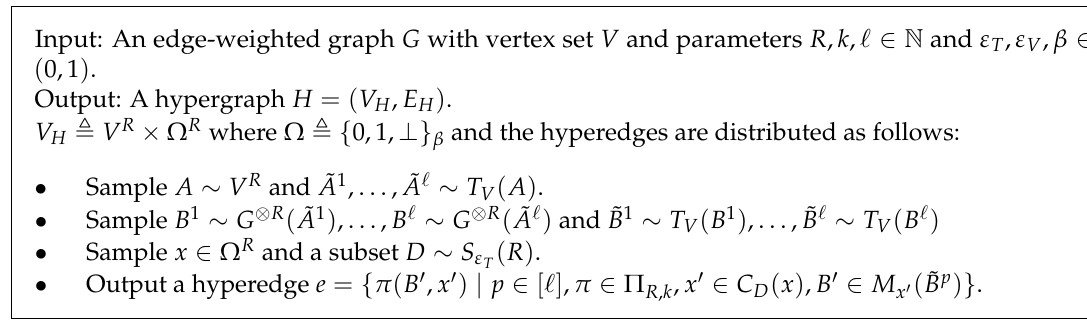
Figure 2. Reduction from SSE to Max UnCut Hypergraph